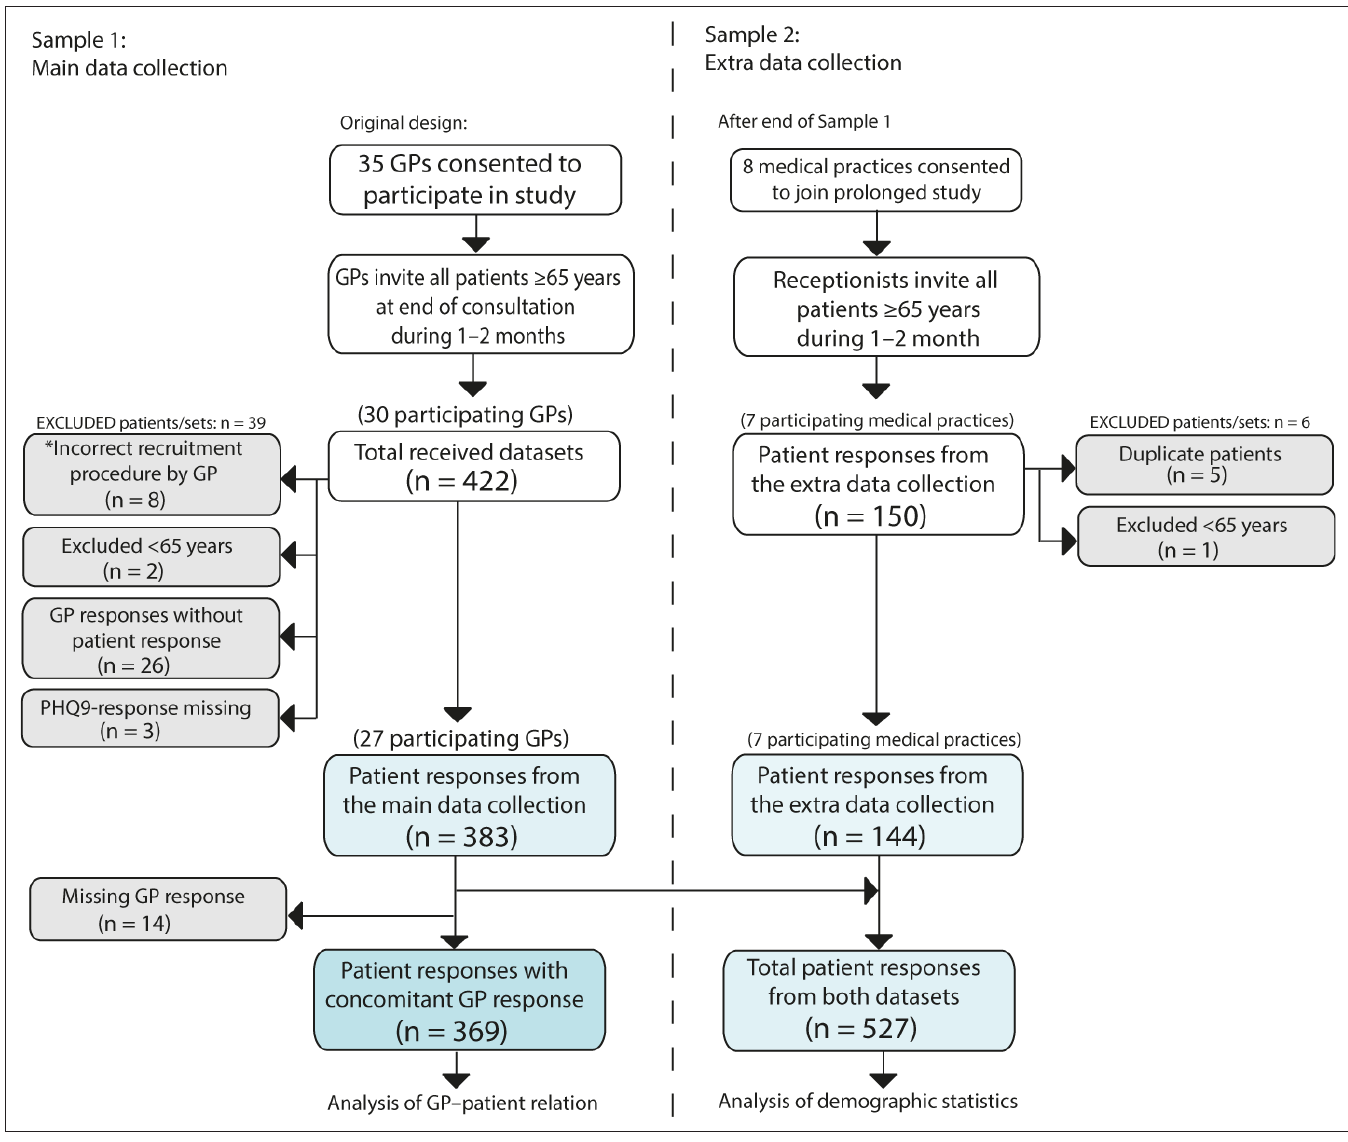
Figure 1 Flow chart of recruitment process and data collection. PHQ- 9 = Patient Health Questionnaire- 9. * Three GPs misunderstood the recruitment procedure, selectively recruiting only patients with depression (instead of every patient aged ≥65